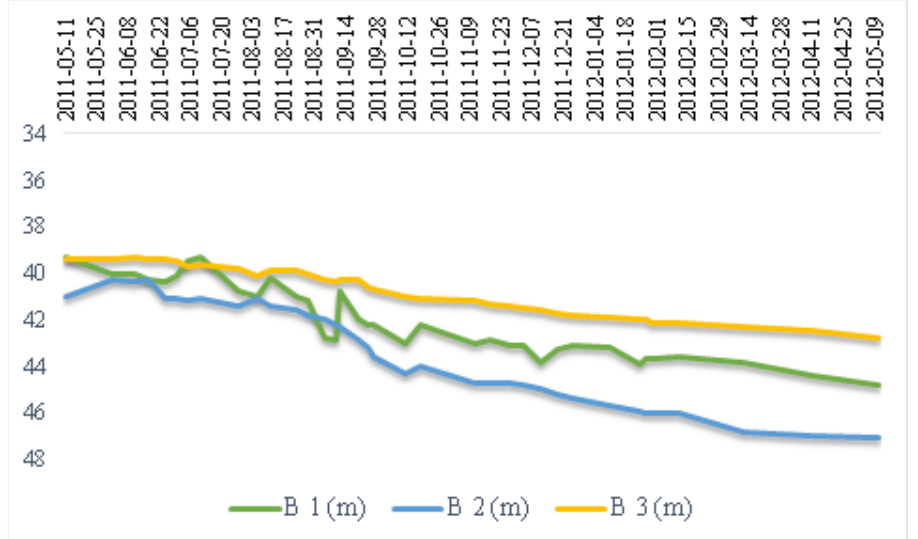
Figure 9. Water changes of three boreholes, B1, B2, and B3, monitored between 2011 and 2012, located in the northern part of the study area (modified after [16]).